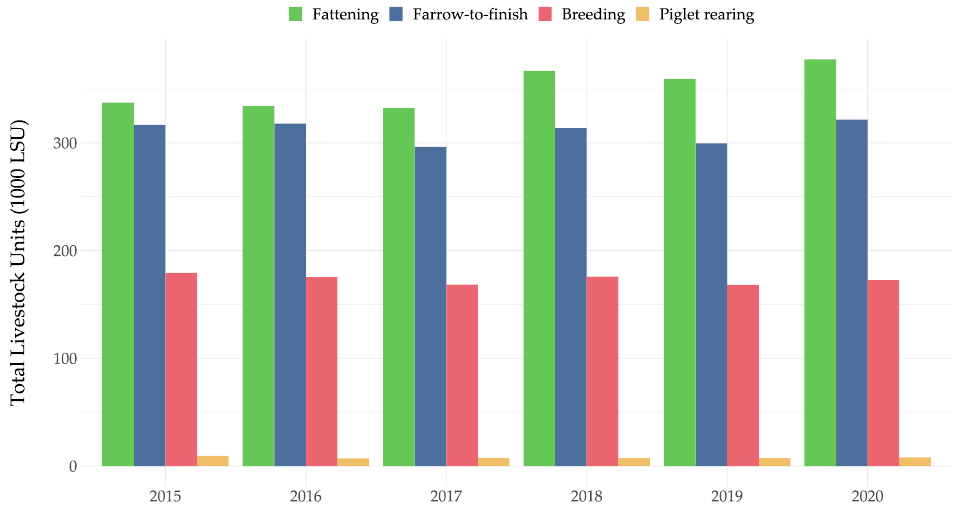
Figure 1. Comparative numbers of 1000 livestock units (LSU) in Austrian pig production systems (included in the study population, i.e., farms where antimicrobials were dispensed and reported) between 2015 and 2020.